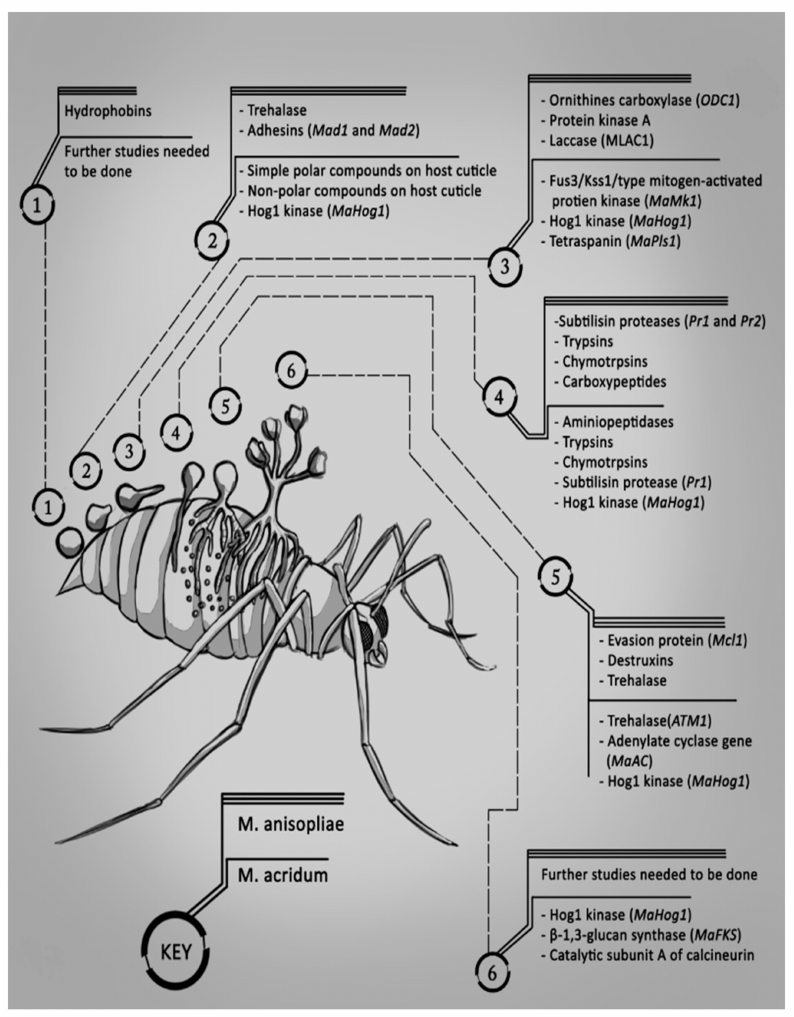
Figure 1. The genes and the proteins encoded produced by M. anisopliae and M. acridum during each stage of